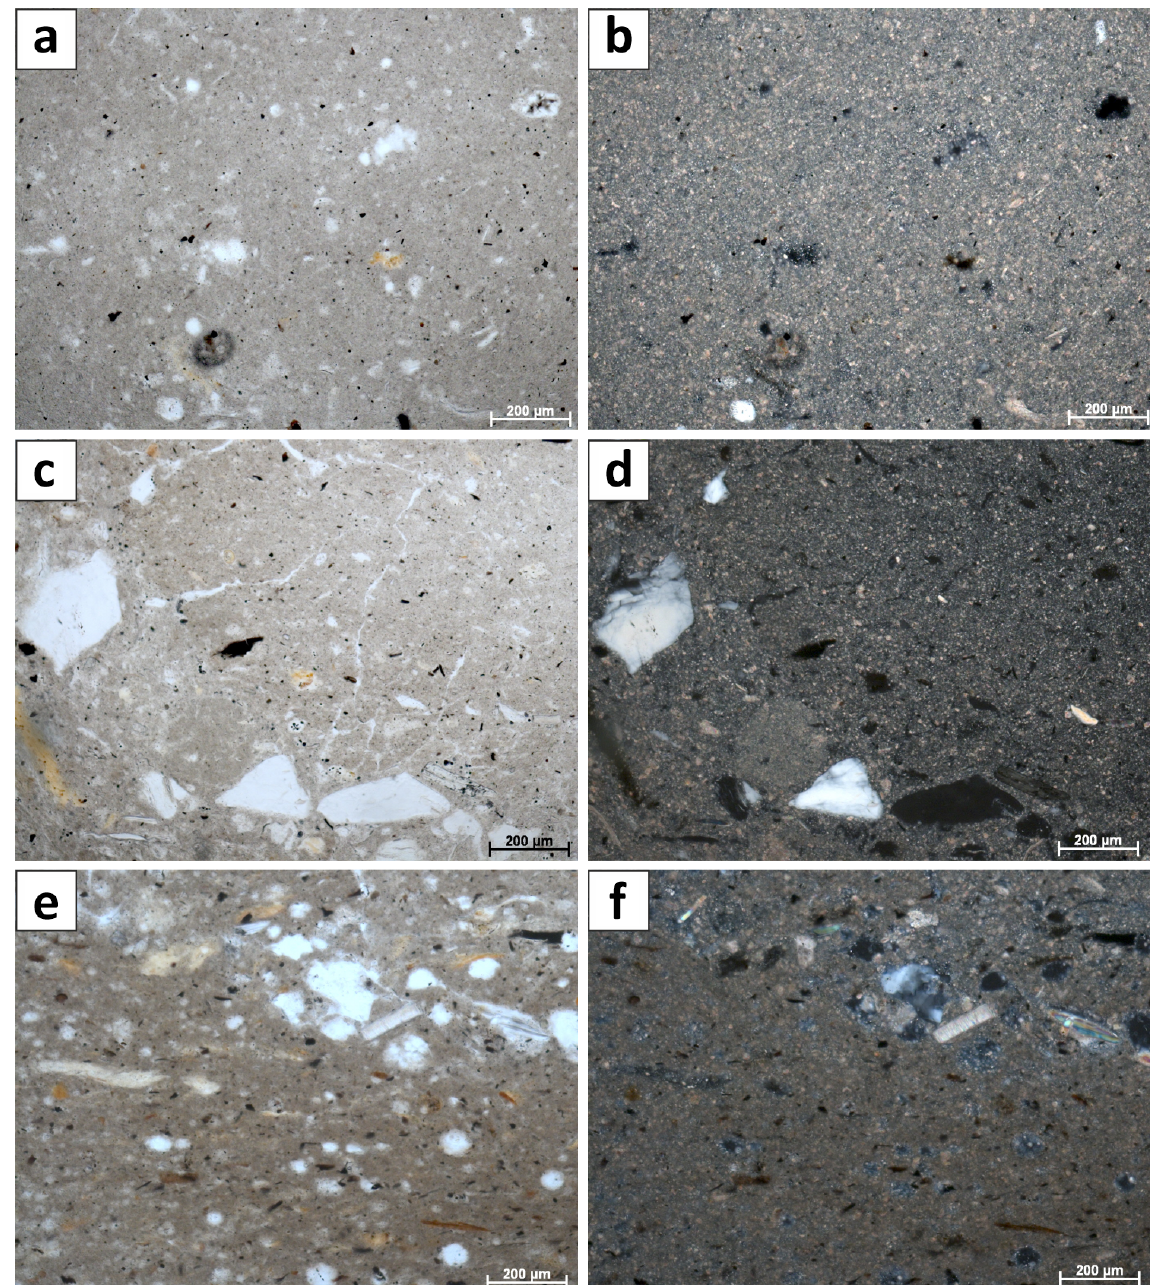
Figure 2. (a) Microfabric of Unit I at 5cm depth in transmitted light. Note the randomly oriented, opaque and brownish plant particles. The microcrystalline matrix is more apparent under crossed polars (b) . (c) Microfabric overview of Unit II at 17cm depth. Large, up-to-fine-sand- scale detrital feldspar grains occur in layers. (d) Same image section under crossed polars. (e) Microfabric of Unit III at 28cm, illustrating the rather compacted shape of the matrix and the elongated appearance of plant detritus. The layering is evident by the occurrence of larger detrital grains in the upper image part. (f) Same section under crossed